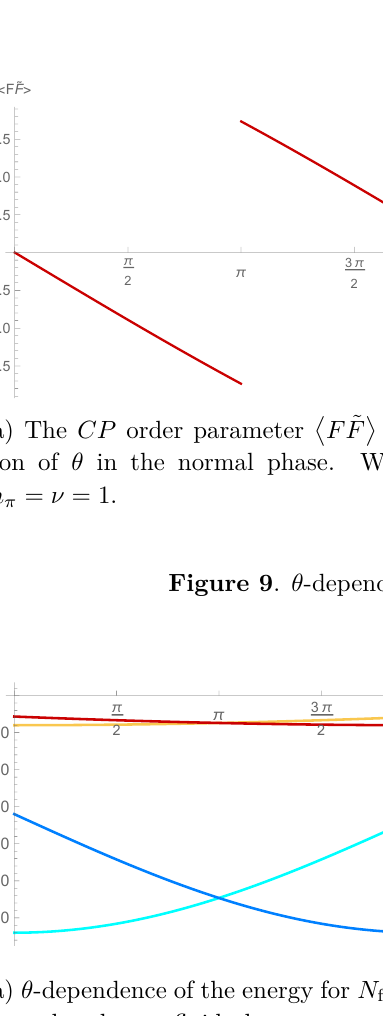
normal and superfluid phase. Figure 10 . θ -dependence of the energy and of the critical chemical potential for N f = 8